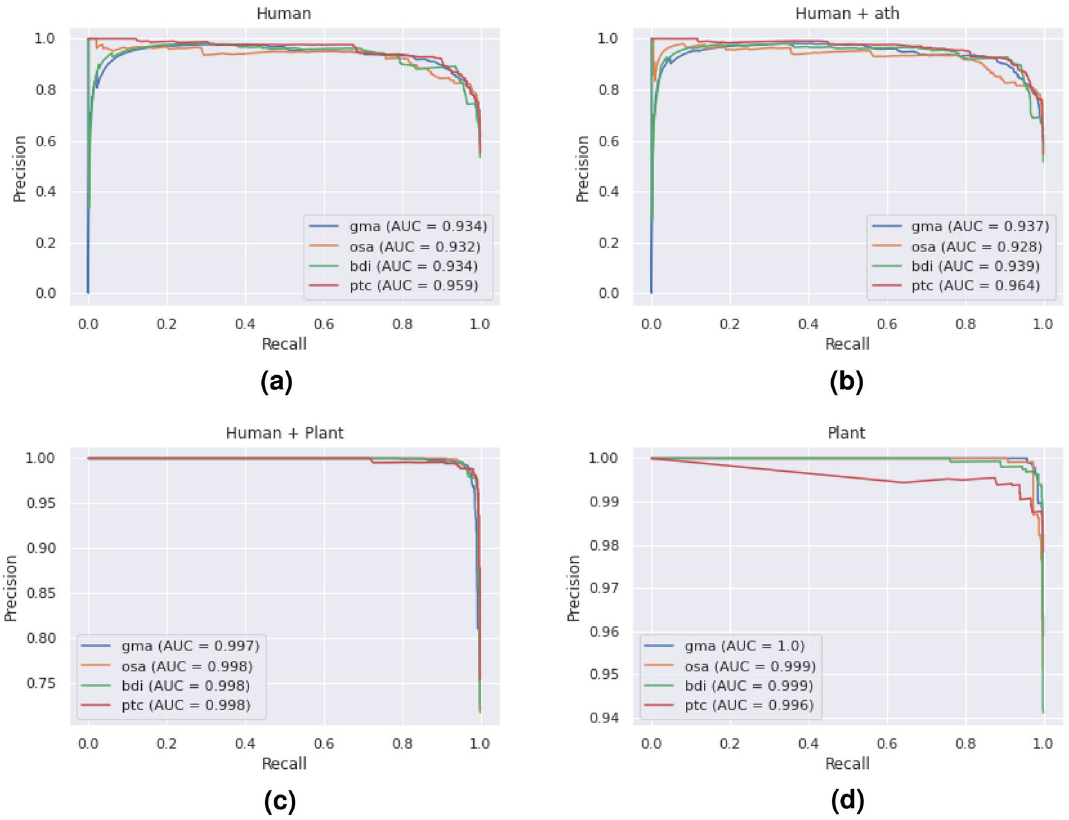
Figure 2. The Precision–Recall curves of each of the four classifiers (Human, Human+ath, Human+Plant, and Plant) for the four plant test species ( Glycine max , Oryza sativa , Populus trichocarpa , and Brachypodium distachyon